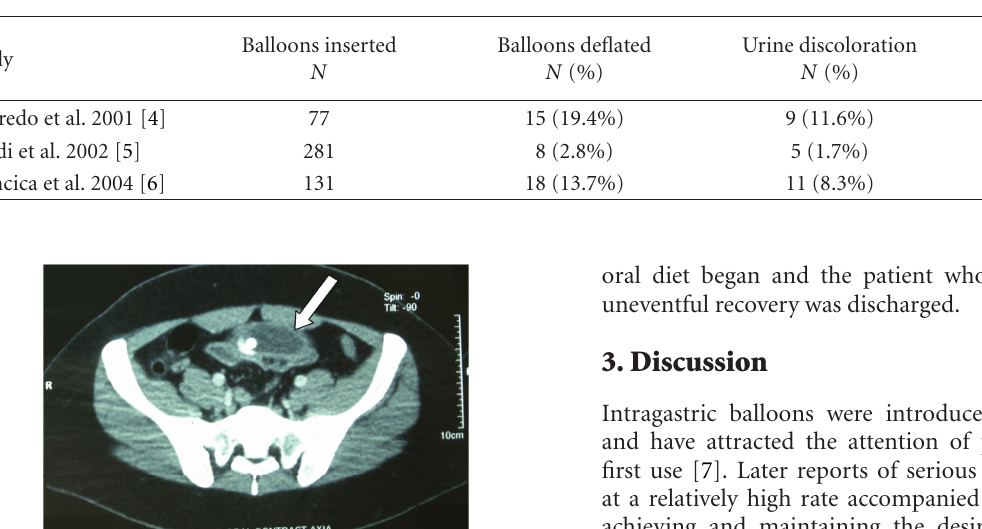
Table 1: Rate of balloon deflation and sensitivity of urine discoloration for detecting it.